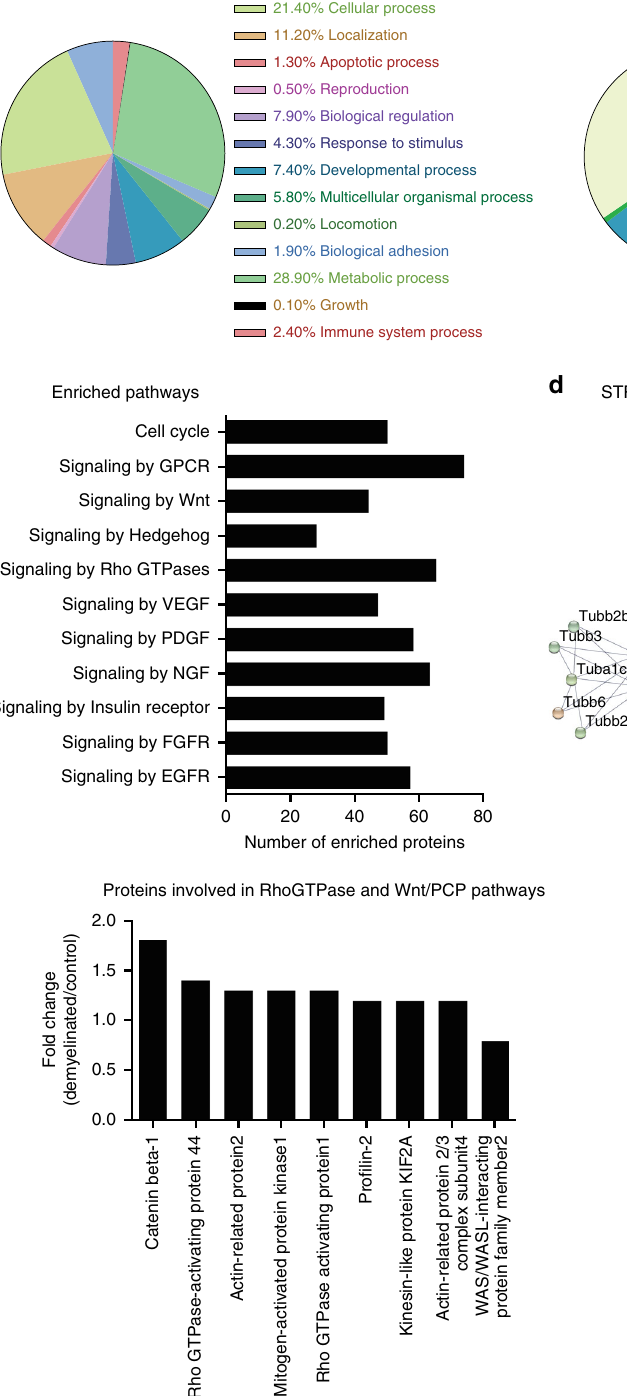
Fig. 1 Proteomics analysis of the SVZ at the peak of demyelination. a , b Gene ontology categories of a upregulated and b downregulated proteins in the SVZ at the peak of demyelination. In total, we identi fi ed 790 proteins that were upregulated by at least 1.2-fold and 166 proteins that were downregulated by 0.8-fold. c Reactome pathway enrichment analysis using both upregulated and downregulated proteins identi fi ed from the proteomics screen. d STRING protein – protein interaction network analysis indicates enriched interactions between Wnt and Rho-GTPase signaling elements identi fi ed in the proteomics screen. Ctnnb1 ( β -Catenin) and Cdc42 (both highlighted in red color) are among the most highly interacting proteins. e Proteins involved in the Rho- GTPase and Wnt/PCP pathways that are altered in the SVZ following a demyelination